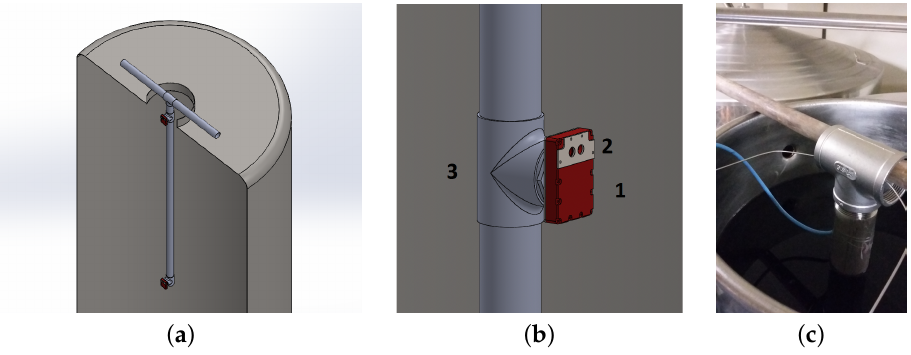
Figure 10. Measurement system. ( a ) Multisensor structure. ( b ) Sensor body (1,2) mounted onto the support tube (3). ( c ) The measurement tube inserted into the Amarone Wine during the in situ measurement.